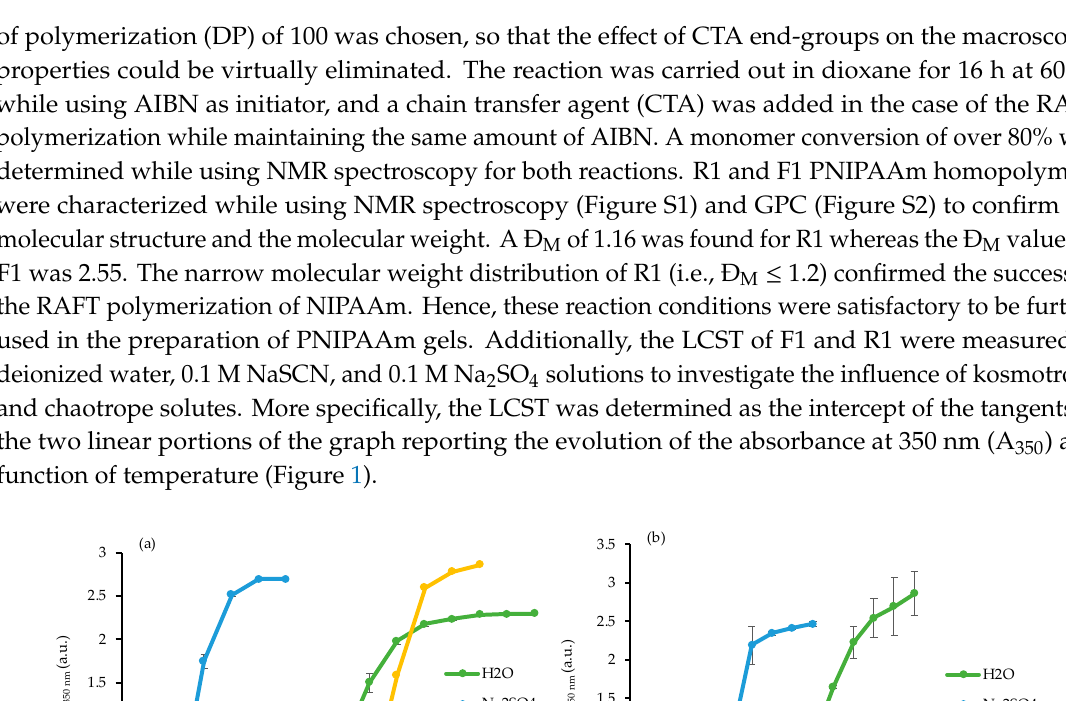
Table 1. Reaction conditions for the preparation of Poly( N -isopropylacrylamide) (PNIPAAm) gels via free radical and reversible addition-fragmentation chain transfer (RAFT) polymerization. Gel_ID